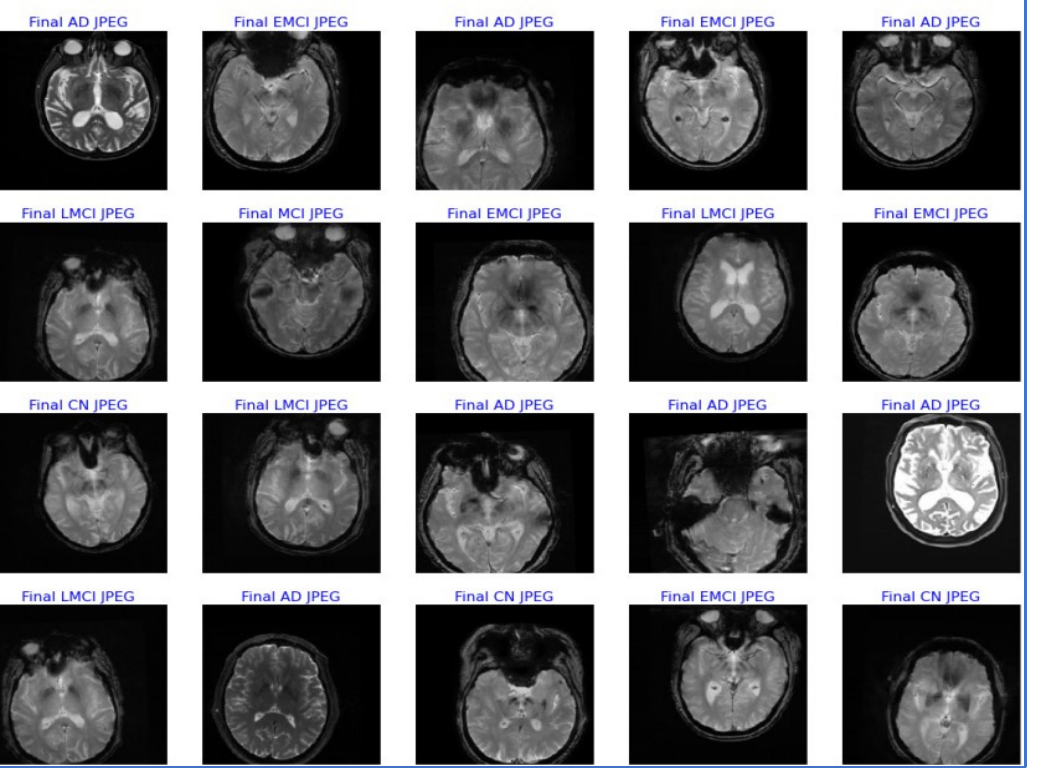
Figure 2. The different augmentation techniques are rotation, flipping, shift, etc. In our approach, some images are 5 degrees rotated, some are flipped, etc. [52].